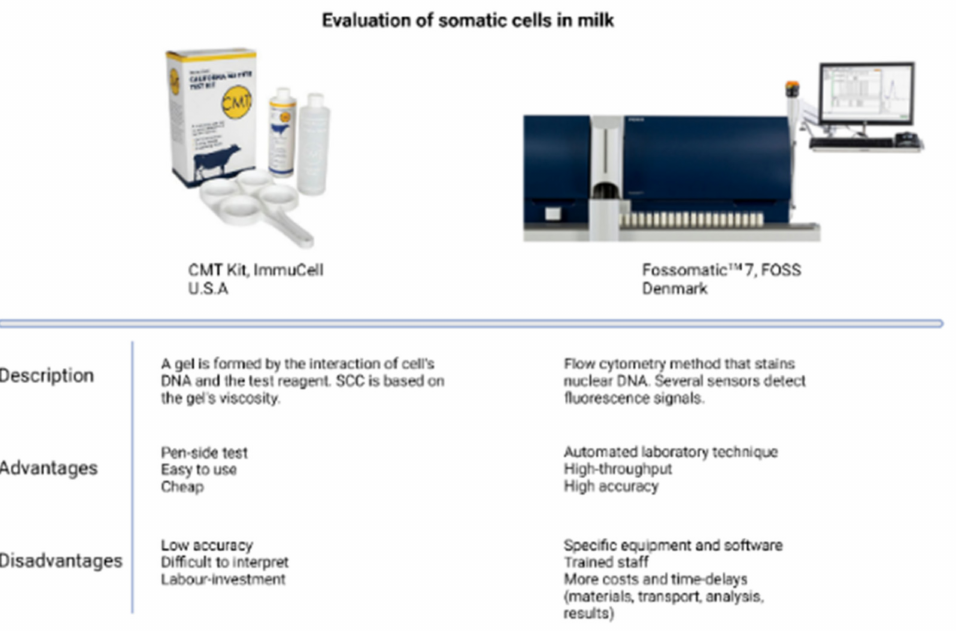
Figure 3. Comparison of two of the most used tests to detect somatic cells in milk. CMT kit image courtesy of ImmuCell (USA); Fossomatic 7 image courtesy of FOSS